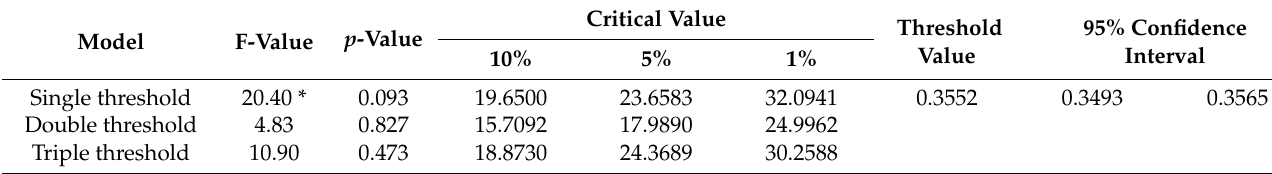
Table 5. Thresholds Corresponding to Different CLT